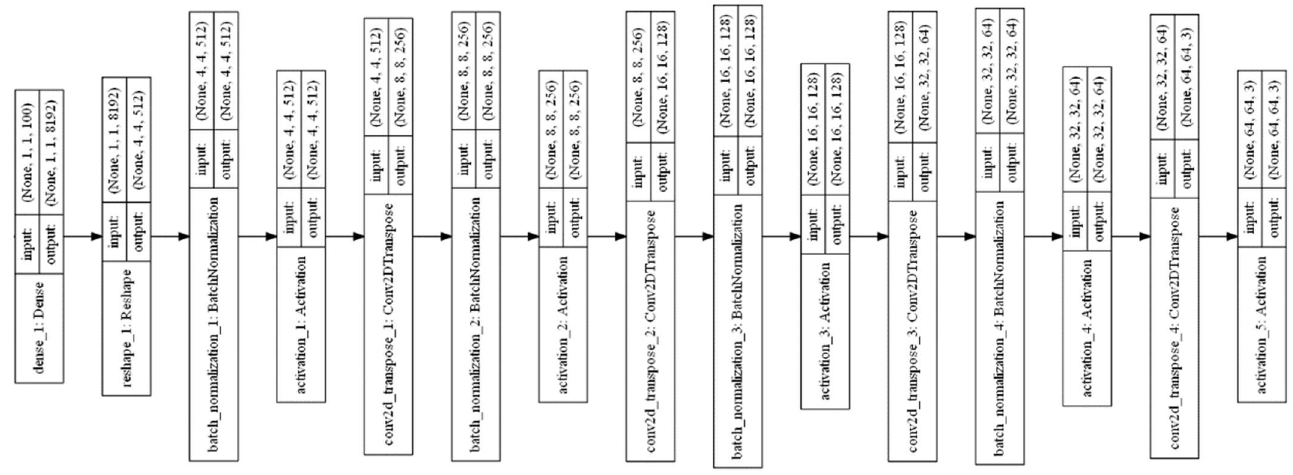
Figure 4. Layered structure of DCGAN generator.